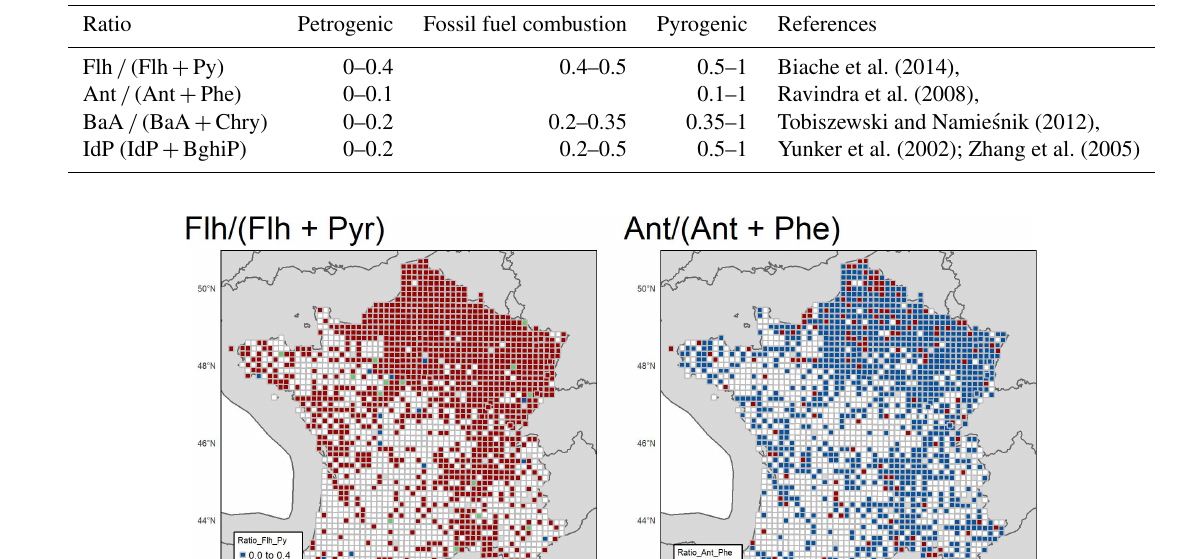
Table 6. Most commonly used molecular diagnostic ratios associated with PAH origins.